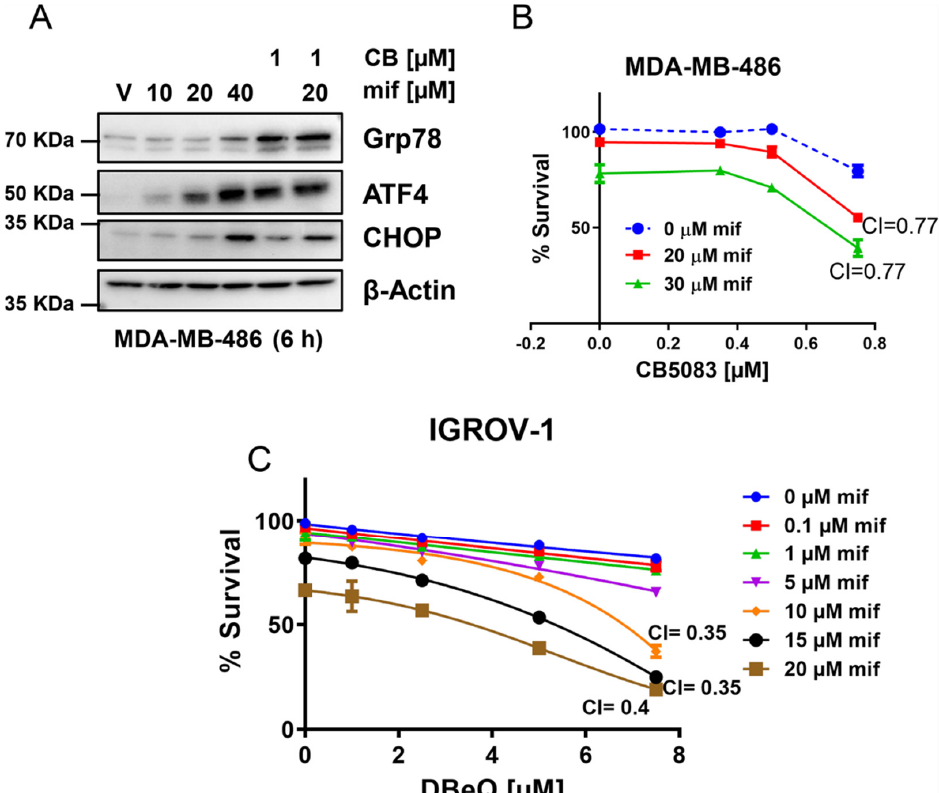
Figure 4. Mifepristone activates the unfolded protein response independent of glucocorticoid, estrogen and progesterone receptor inhibition. ( A ): Triple-negative breast cancer cell line (MDA- MB-468) was incubated with indicated compounds for 6 h. Whole cell lysates were then subjected to immunoblotting with antibodies for indicated proteins. β -Actin was used as loading control. Uncropped immunoblots can be found in Figure S7. ( B ): MDA-MB-468 cells were treated with different concentrations of CB-5083 up to 0.75 µ M and different concentrations of mifepristone (20 µ M and 30 µ M) for 72 h. Cell viability was measured using the SRB assay and dose–response curves were plotted with GraphPad Prism. CI stands for combination index. ( C ): IGROV1 cells were treated with indicated concentrations of DBeQ and mifepristone for 72 h. Cell viability was measured using SRB assay and dose–response curves were generated using GraphPad Prism. All experiments were performed in three biological